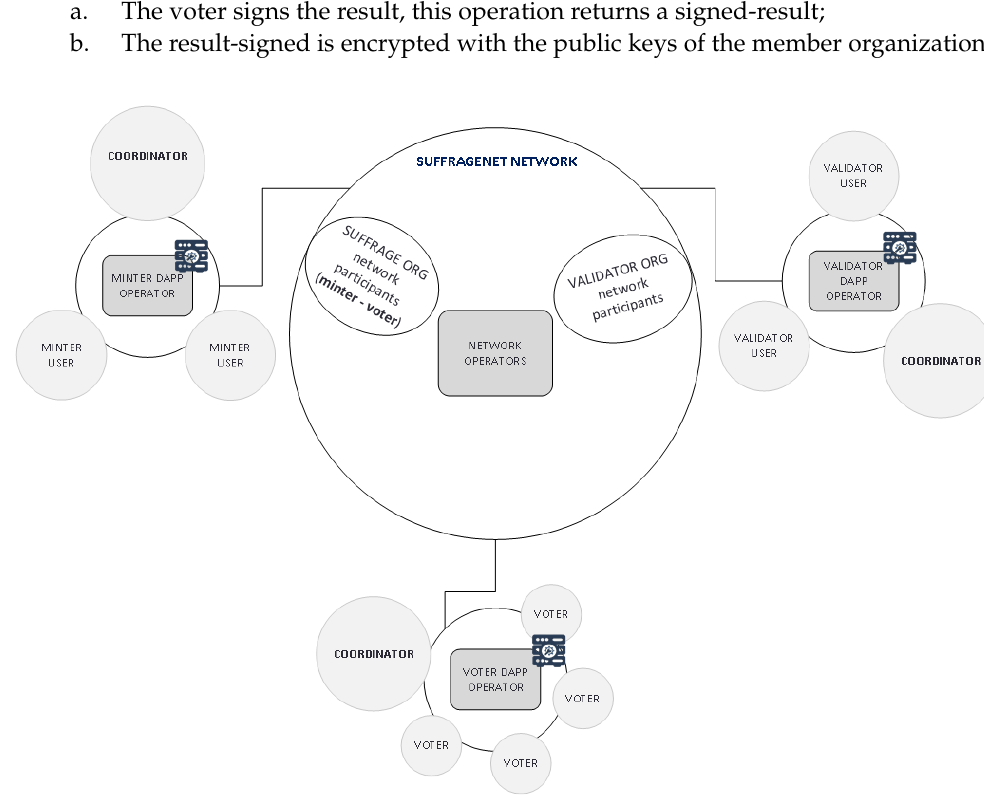
Figure 12. Depiction of users and operators of the blockchain